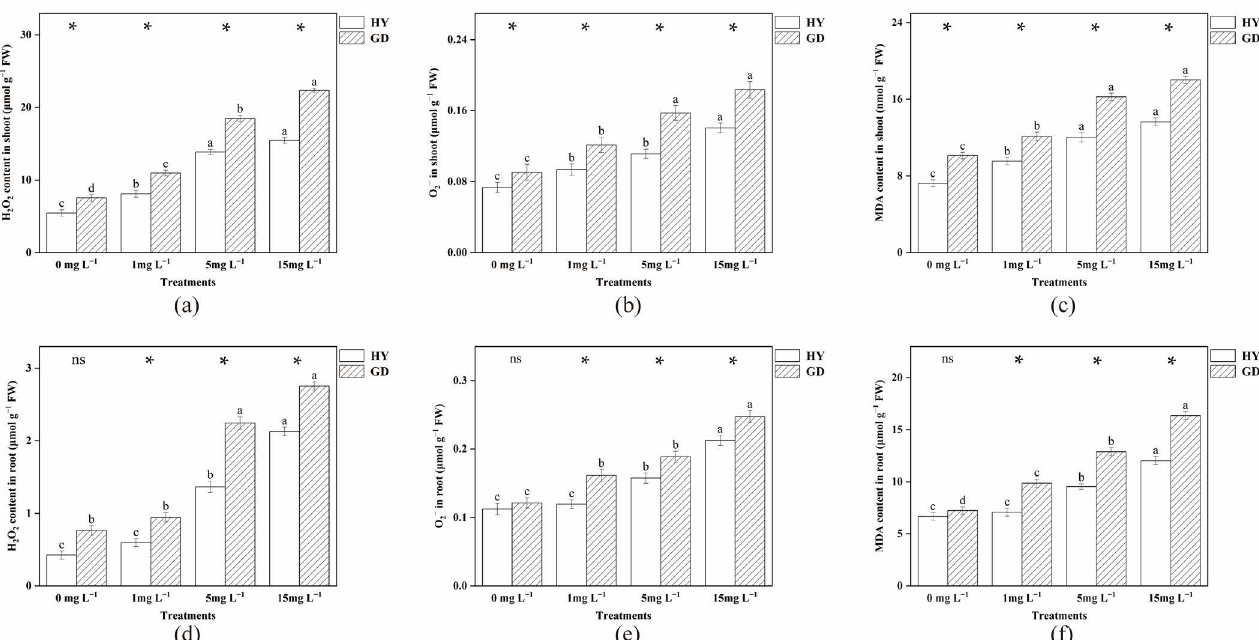
Figure 2. Shoot H 2 O 2 ( a ), O 2 ( b ), MDA content ( c ) and root H 2 O 2 ( d ), O 2 − ( e ), and MDA content ( f ) of two Chinese flowering cabbage under different doses of As. * indicates significant ( p < 0.05) differences between two cultivars at the same As treatment by t -test.